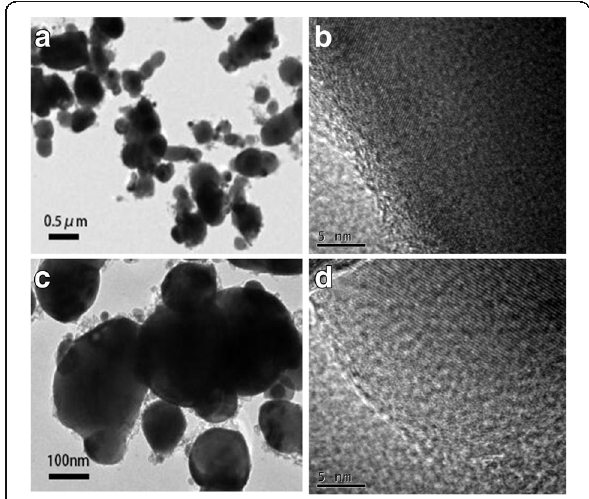
Fig. 5 Charge/discharge curves of LiNi 0.5 Mn 1.5 O 4 and LiCr x Ni 0.5 − 0.5x Mn 1.5 − 0.5x O 3.95 F 0.05 ( x = 0.025, 0.05, 0.075) at 0.1